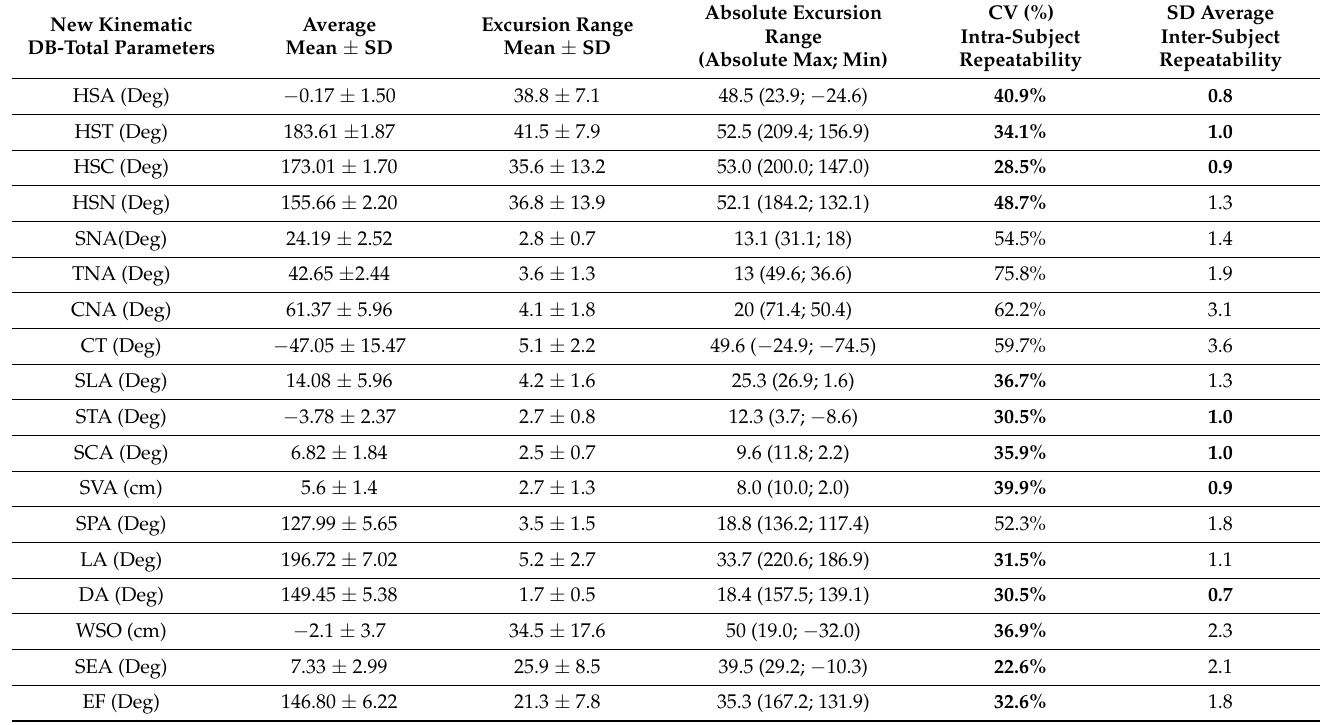
Table 3. Mean value, Mean Excursion Range, SD Average, Absolute Excursion Range (absolute inter- subject min and max degree of curves for each group), Coefficient of Variation (CV) of intra-subject repeatability and inter-subject repeatability. Dorsal Angle (DA), Lumbar Angle (LA), Elbow